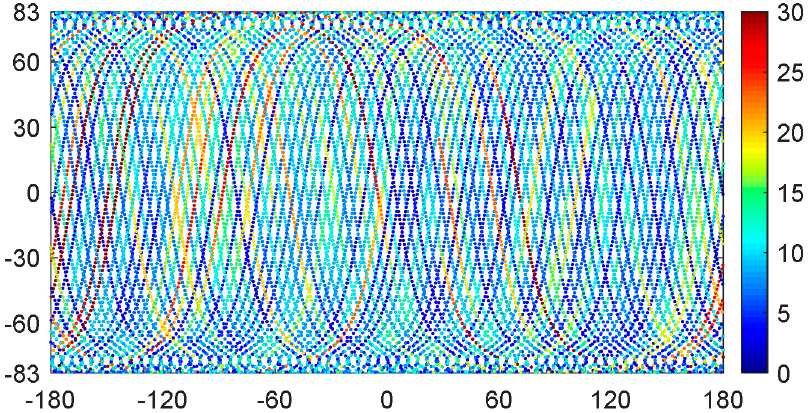
Figure 12. 3D orbit difference (cm) between BDS-based POD (without BDS GEOs) and GPS-based POD along CSES satellite ground tracks from DOY 202 to DOY 206, 2018. BDS products are calculated using PANDA.